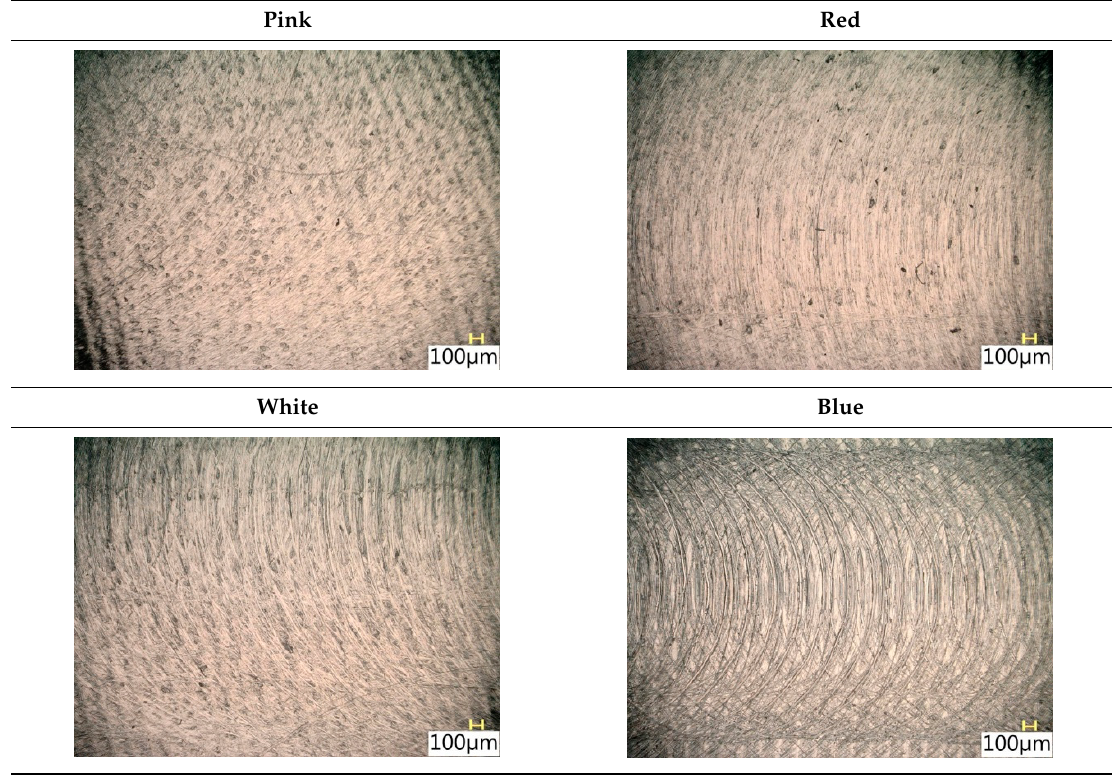
Table 6. Surface texture after brushing with the “high” spring in the offset adjustment sleeve. Pink